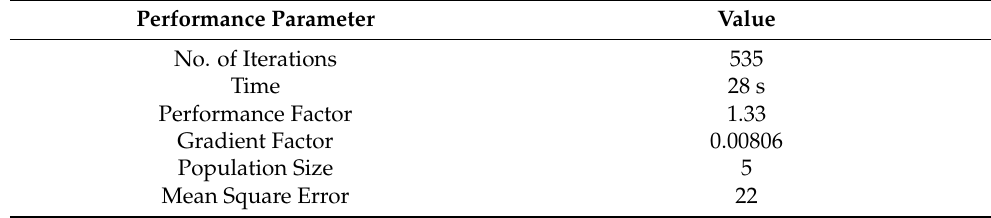
Table 5. Various parameters and their values.